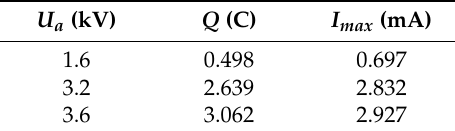
Table 6. Characteristic quantities of leakage current at di ff erent applied voltage ( γ 20 = 3000 µ S / cm, t = 8